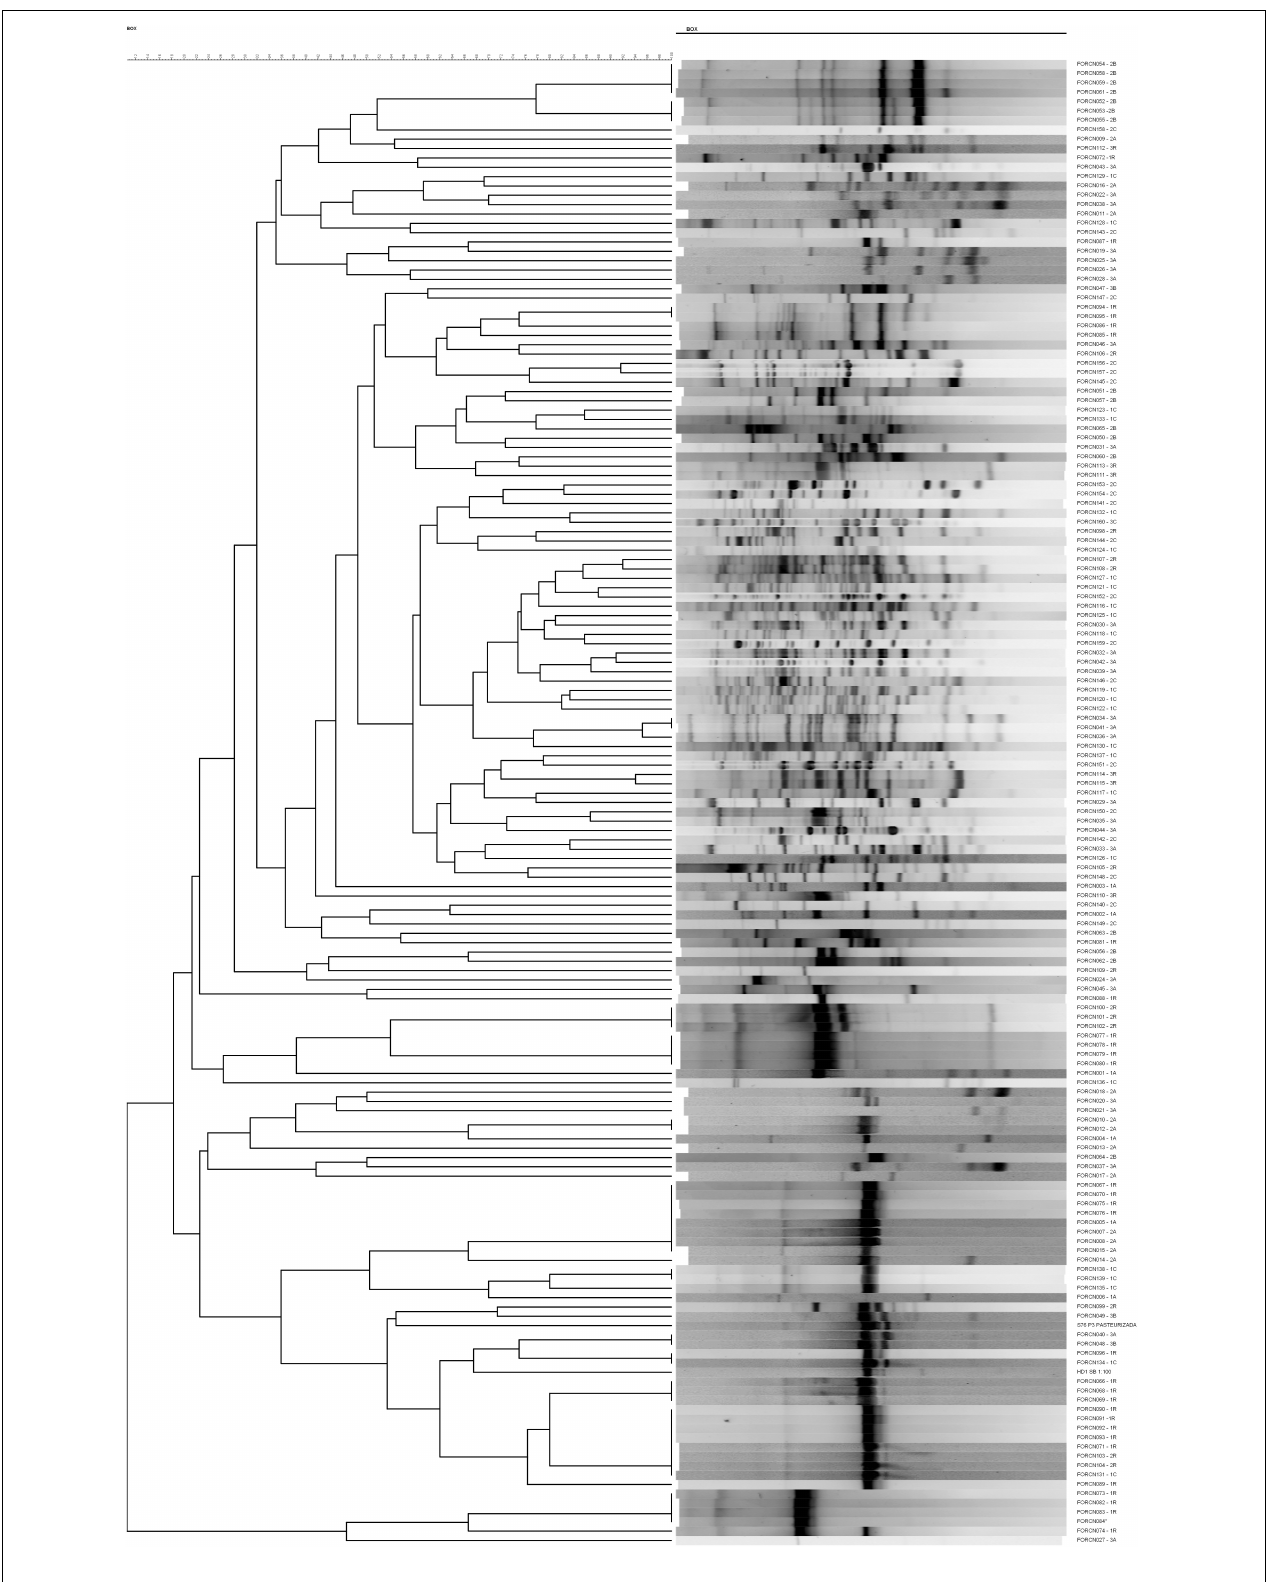
FIGURE 2 | UPGMA similarity dendrogram of BOX-PCR fingerprinting. The dendrogram was generated of fingerprinting patterns of 157 bacterial isolates from sugarcane niches (apoplast, central region of the internodes, roots) and the digestive tract of the giant borer ( Telchin licus licus ).